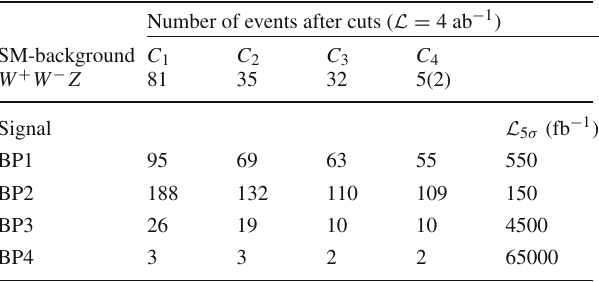
Table 14 The cut-flow for signal and backgrounds for BP1, BP2, BP3 and BP4 at 1 TeV ILC and the required integrated luminosity for 5 σ significance for the e + e − → 4 (cid:10) + E / T channel. The bracketed term in C 4 cut denotes the surviving number of events for M eff < 500 GeV cut for the background Number of events after cuts ( L = 4 ab − 1 )